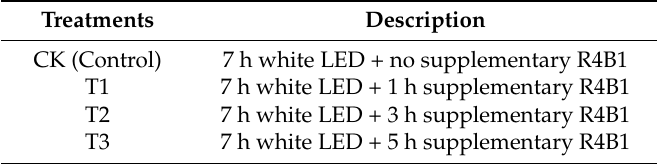
Table 1. The different supplementary light designs used in the